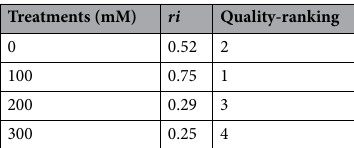
Table 3. Quality sequencing of the Lonicerae Japonicae Flos samples affected by NaCl.